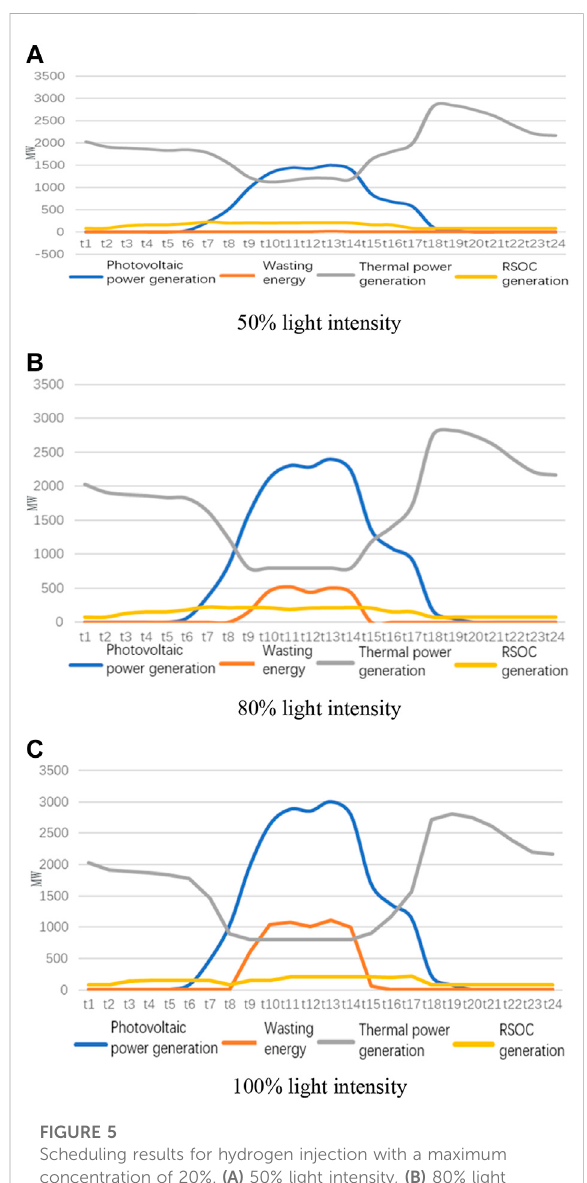
FIGURE 5 Scheduling results for hydrogen injection with a maximum concentration of 20%. (A) 50% light intensity, (B) 80% light intensity, (C) 100% light intensity.